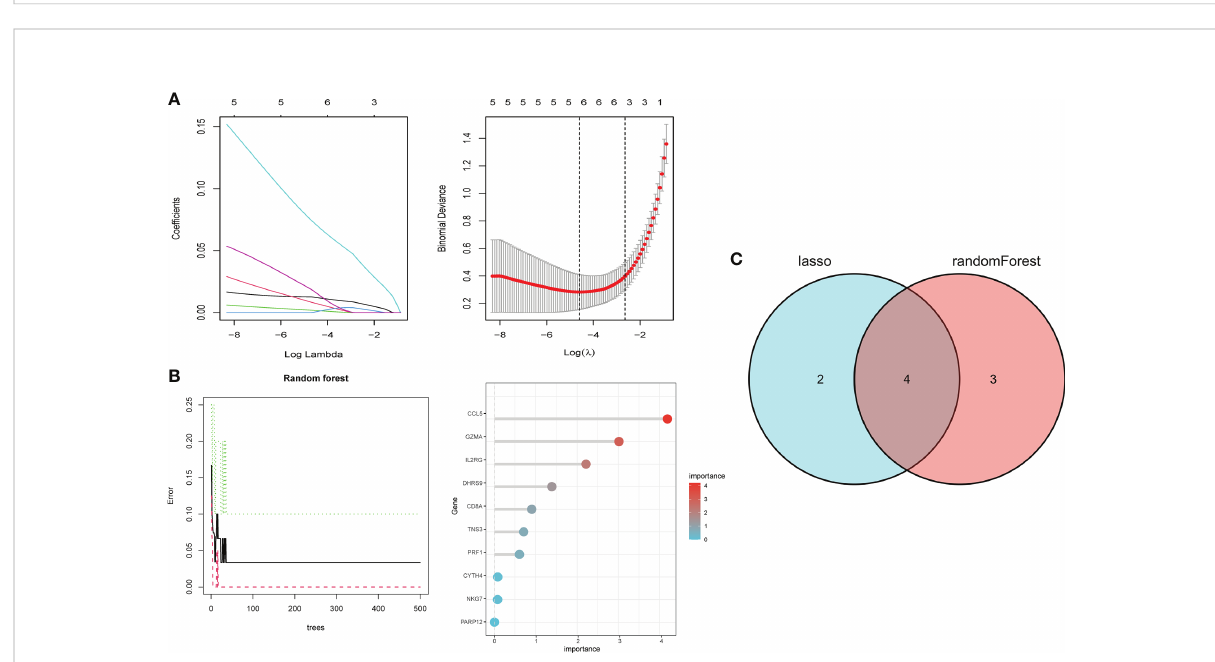
FIGURE 3 Hub gene selection. (A) Adjustment of feature selection in the minimum absolute shrinkage and selection operator model (lasso). (B) randomForest error rate versus the number of classi fi cation trees, the top 20 relatively important genes. (C) Three algorithmic Venn diagram screening